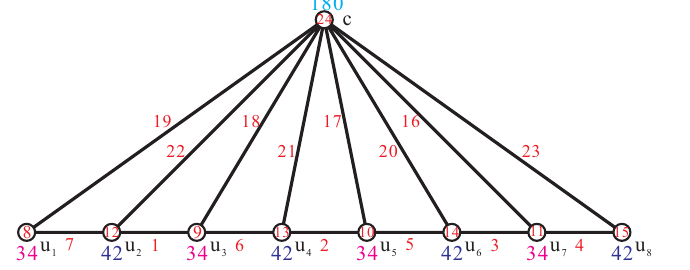
Figure 3. The local antimagic total labeling of F 8 .